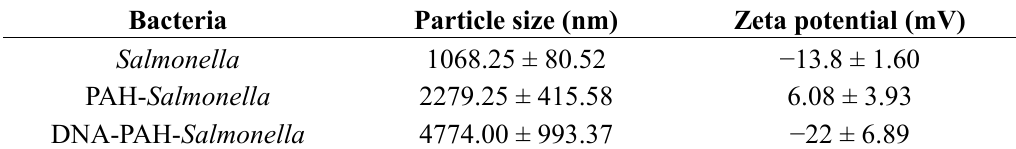
Table 1. Particle size and zeta potential values of Salmonella ( n = 4).